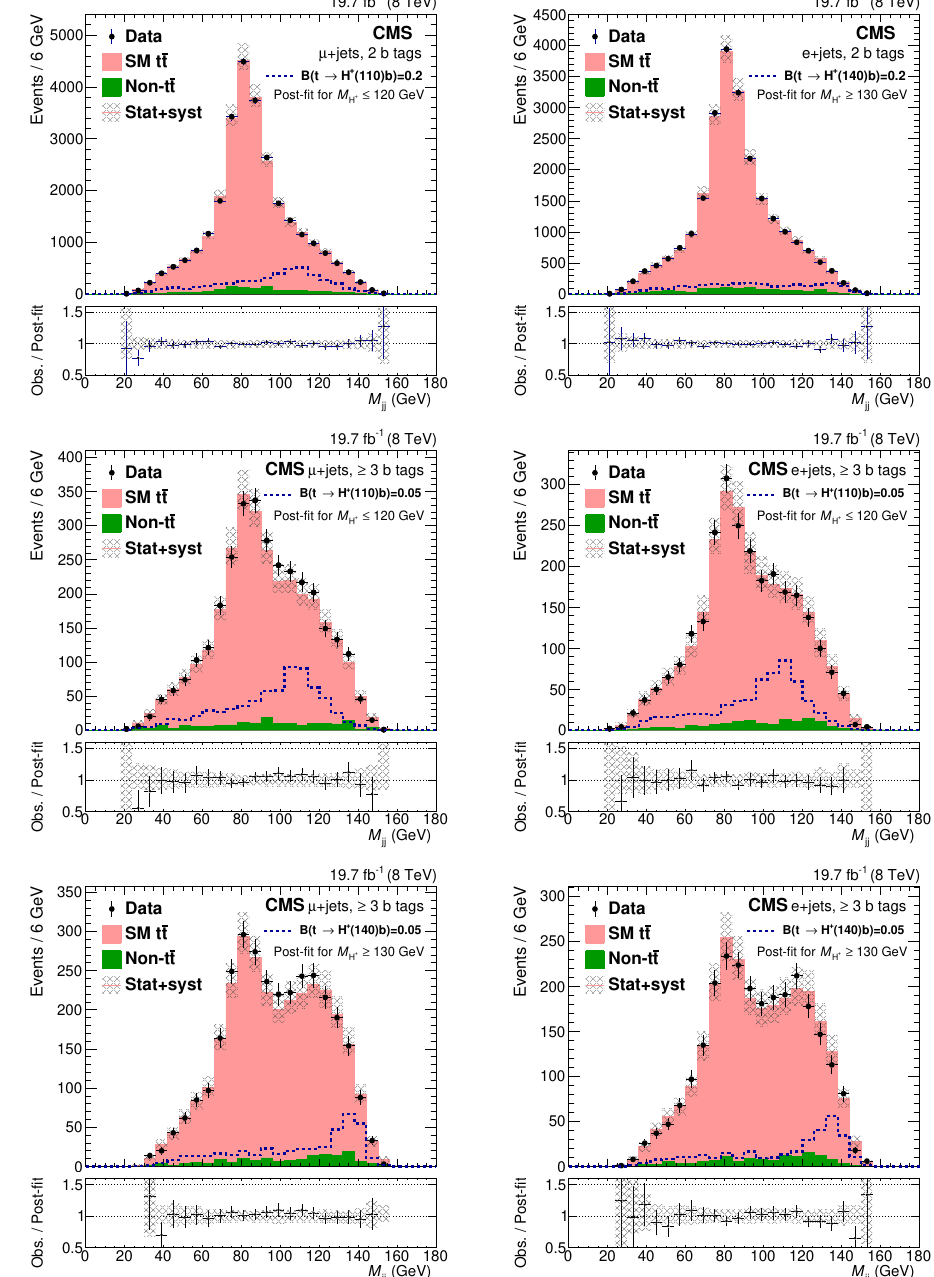
Figure 2 . Post-(cid:12)t with a null-H + hypothesis on the expected dijet mass distributions from SM backgrounds (cumulative (cid:12)lled histograms) and their ratio of observed to predicted yields for the (cid:22) +jets (left column) and e+jets (right column) channels. In the (cid:12)rst row, events are shown for two b tags together with the (cid:12)t procedure for a H + signal ( M = 110 GeV in left and 140 GeV in right). H + The second (third) row shows the results for events with at least three b tags in the (cid:12)t procedure for the H + search with M = 90{120 (130{150) GeV. The dijet distributions are compared with H + the H + signal shape (dashed line) for M = 110 and 140 H +